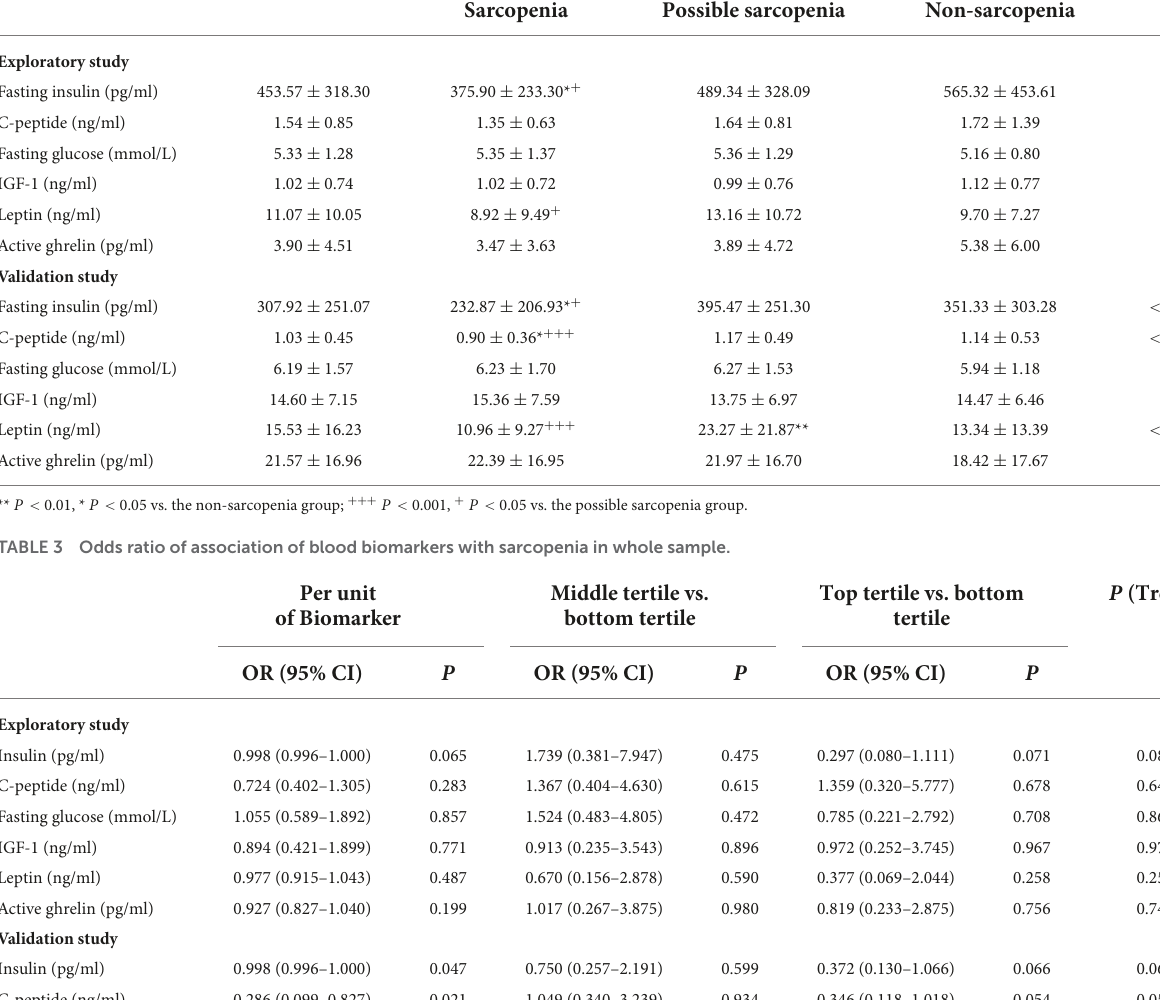
TABLE 2 Blood biomarker concentrations of sarcopenia groups in frailty intervention trial (FIT) study subjects and Singapore longitudinal ageing studies (SLAS) subjects.